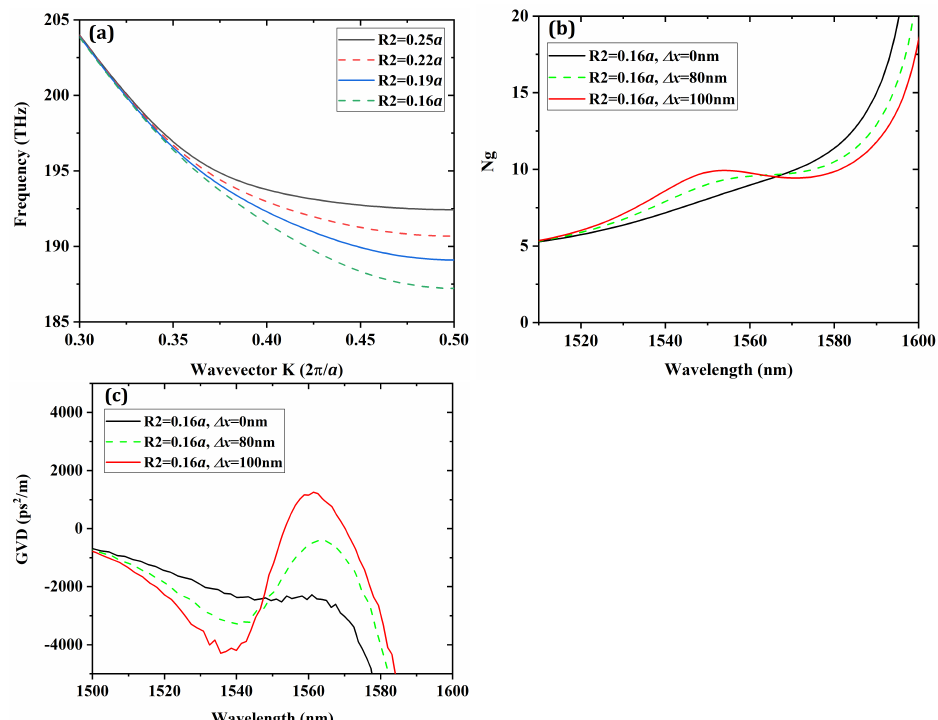
Figure 8. ( a ) Dispersion profiles of the guided mode for various R2, ( b ) the group index and ( c ) GVD parameters for various R2 and ∆ x . The thickness of the silicon film in this 3-D FDTD simulation is 220 nm, the lattice period a is 400 nm and the radius R is 100 nm, while the R 2 and ∆ x values are shown in the legends.